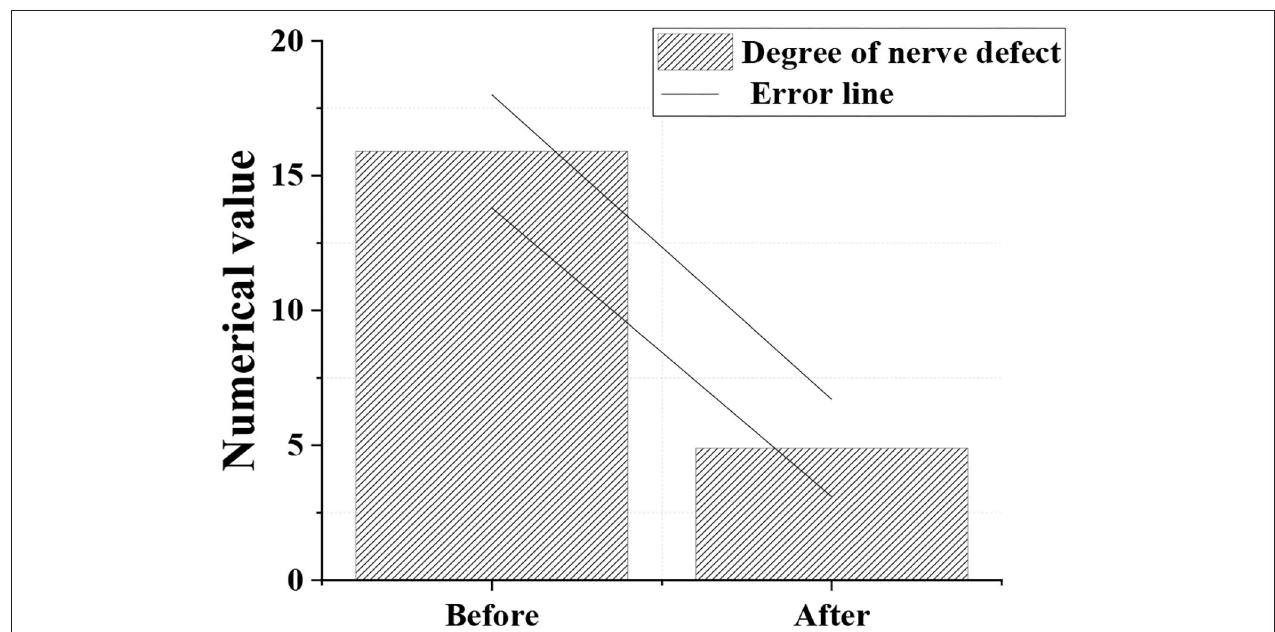
FIGURE 8 | Comparison of degree of neurological